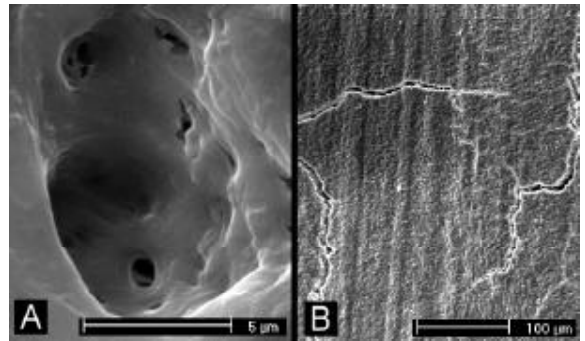
FIGURA 7- grupo 5 – dentes instrumentados e condicionados com EDTA líquido: A – túbulo dentinário parcialmente desobstruído (aumento 6400X); B – remoção